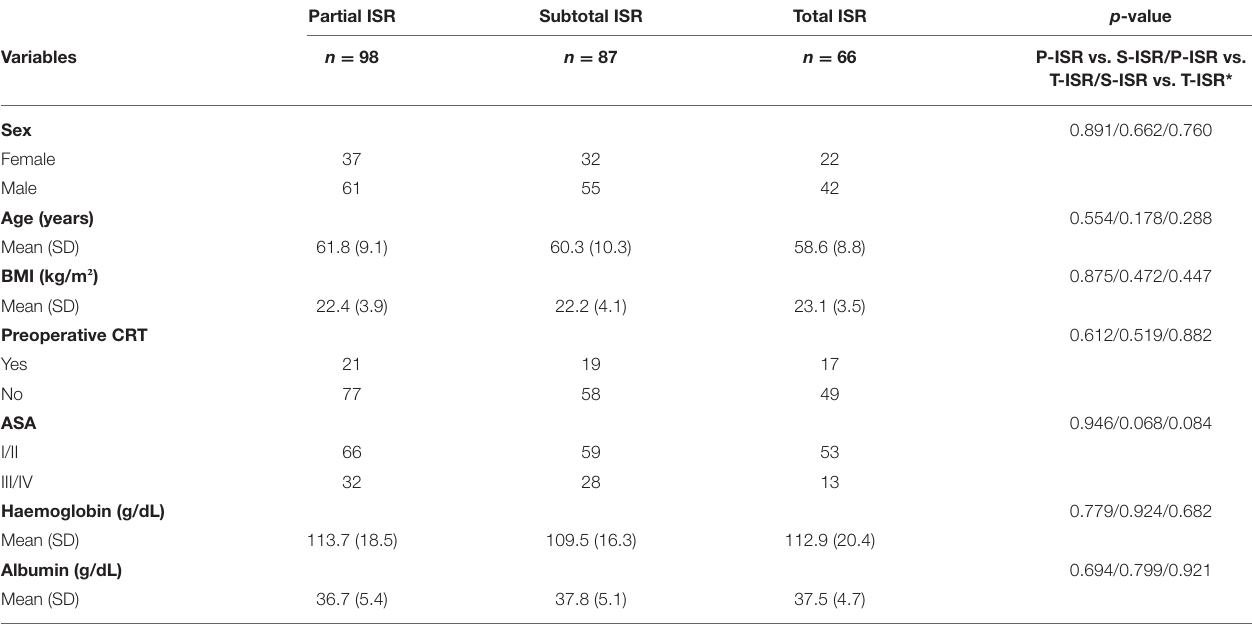
TABLE 1 | Demographics and clinical characteristics of patients. Partial ISR Subtotal ISR Total ISR p